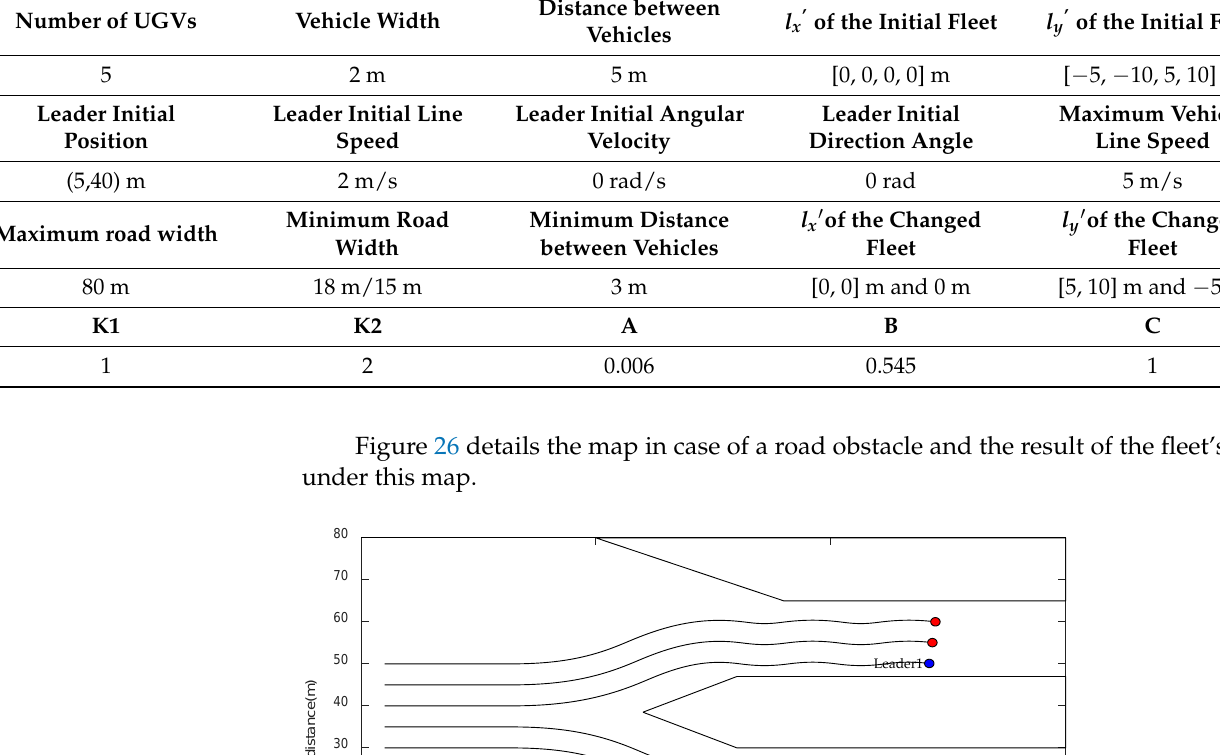
Table 3. The relevant parameters in case of road obstruction.